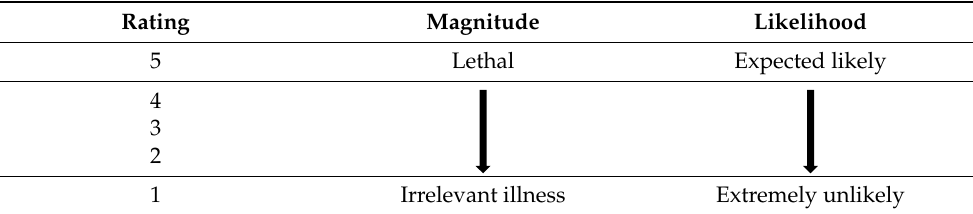
Table 2. Magnitude and likelihood scales [13].